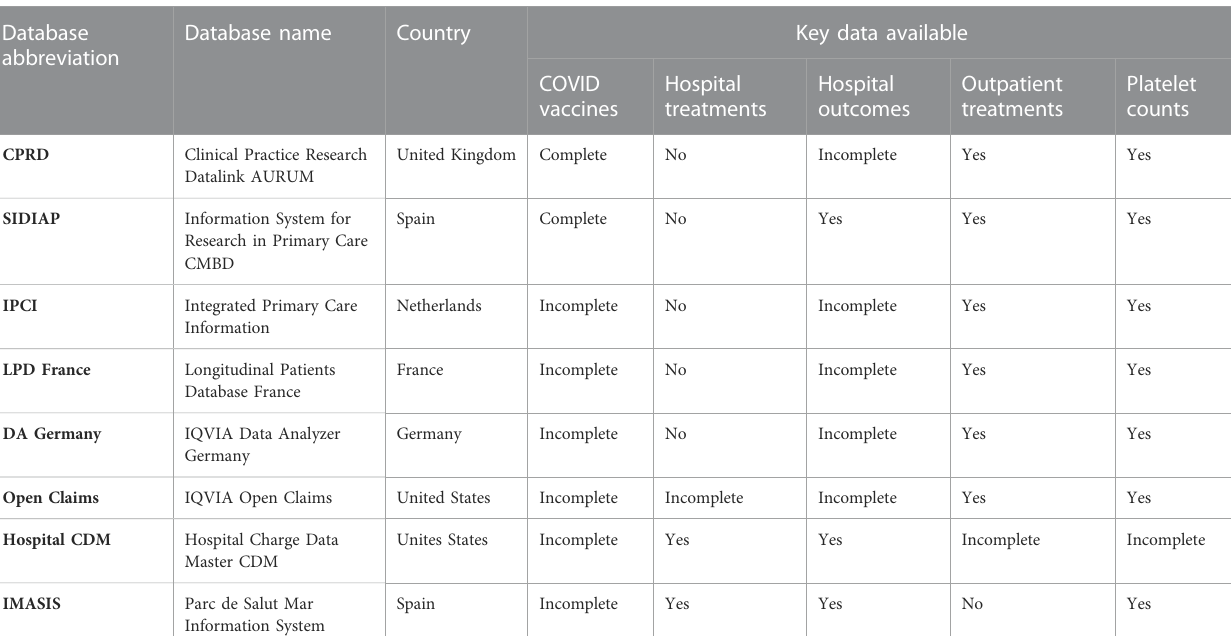
TABLE 1 List of databases included in